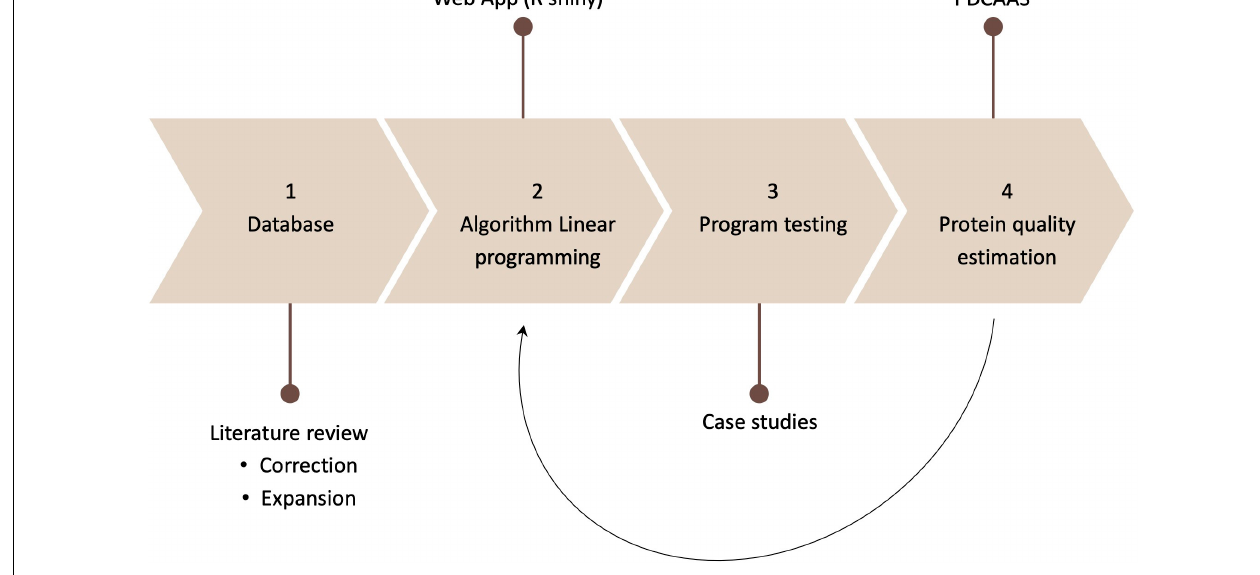
FIGURE 1 | Methodology.